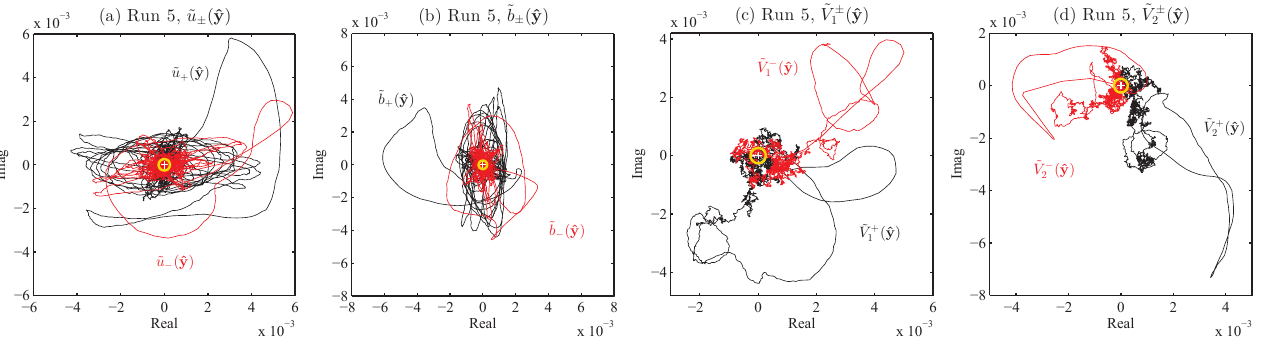
Figure 7. Phase portraits from Run 5; white + marks the origin; variables are normalized by N 3/2 , N = 128. Yellow circles indicate predicted average magnitude. ˜ V ± ( ˆ y , t ) [ ˜ b ( ˆ y , t ) ( ˆ y , t )] . Please see Section 2.4 for detailed discussions of relations be- ˜ u and ˜ V ± 2 ∼ − ± ± tween